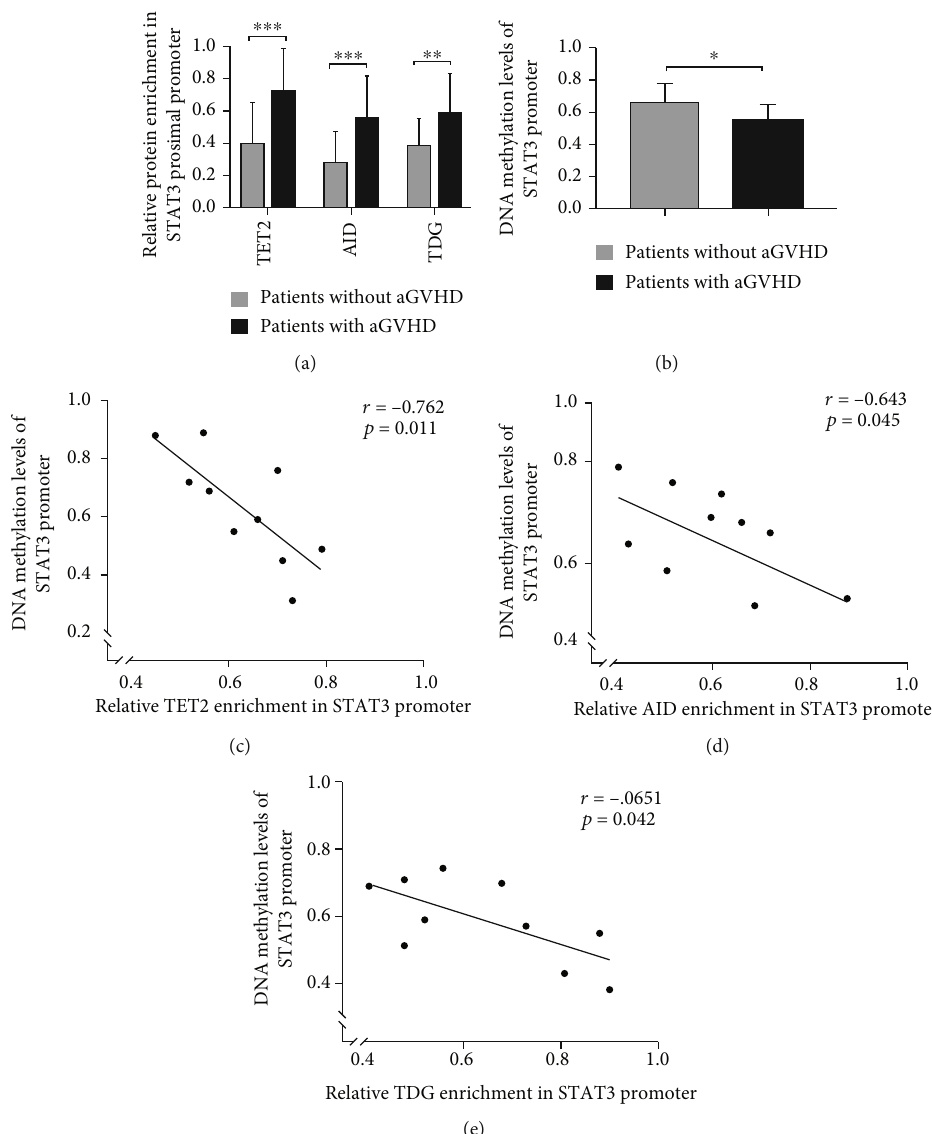
Figure 2: Binding level of TET2/AID/TDG in STAT3 promoter was extremely upregulated in aGVHD CD4 + T cells. (a) ChIP-qPCR analysis of the binding level of TET2/AID/TDG in the STAT3 promoter region in CD4 + T cells from patients with ( n = 23 ) or without ( n = 23 ) aGVHD. (b) DNA methylation level of STAT3 promoter in CD4 + T cells from aGVHD patients ( n = 10 ) or non-aGVHD patients ( n = 10 ) ( 0 = unmethylated ; 0 : 5 = 50 % methylated ). (c – e) Correlation between relative TET2, AID, and TDG enrichment and DNA methylation in STAT3 promoter in aGVHD-CD4 + T cells ( r = − 0 : 762, p = 0 : 011 ; r = − 0 : 643 , p = 0 : 045 ; r = − 0 : 651 , p = 0 : 042 ; n = 10 ) ( 0 = unmethylated ; 0 : 5 = 50 %